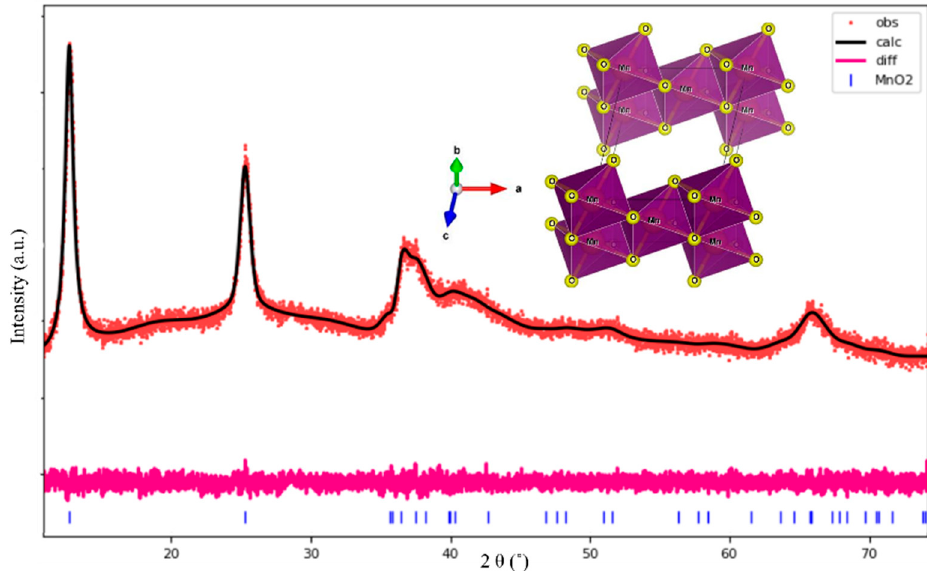
Figure 1. Rietveld refinement fit of δ -MnO 2 obtained after using monoclinic structure in the C2/m space group in the 2 θ range of 10 to 75°. The red dots, black line, and pink line represents observed, calculated, and difference profiles, respectively. The vertical blue tick marks below the difference profile denotes the position of Bragg reflections.